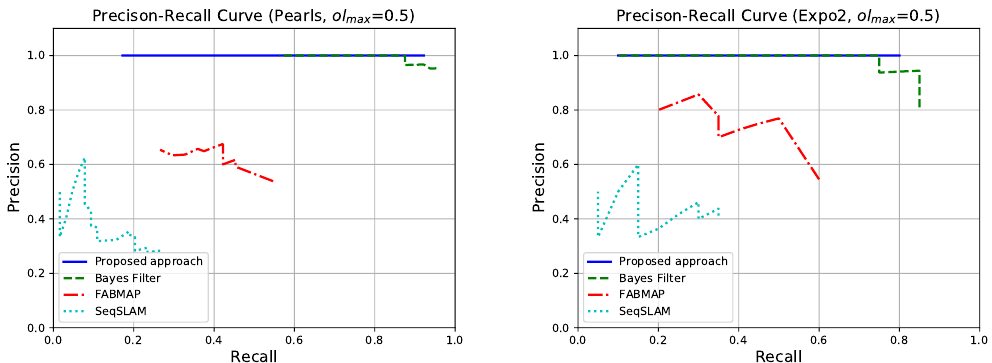
Figure 10. Precision-Recall curves obtained with ol max = 0.5. A method is not shown in a plot when it was not able to recognize previously seen places.